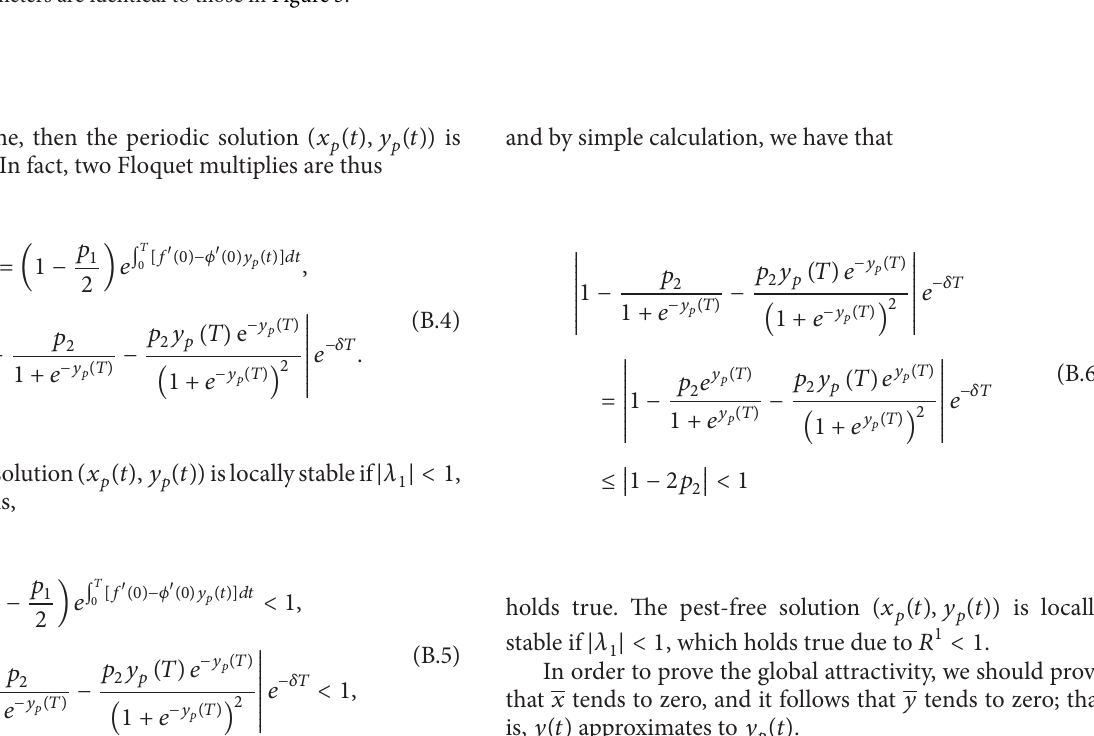
Figure 6: Coexistence of two stable attractors of model (24) for 𝜎 = 5 , and the initial conditions from left to right are (𝑥 0 ,𝑦 0 ) = (1, 1.2) , (2,3) . The other parameters are identical to those in Figure